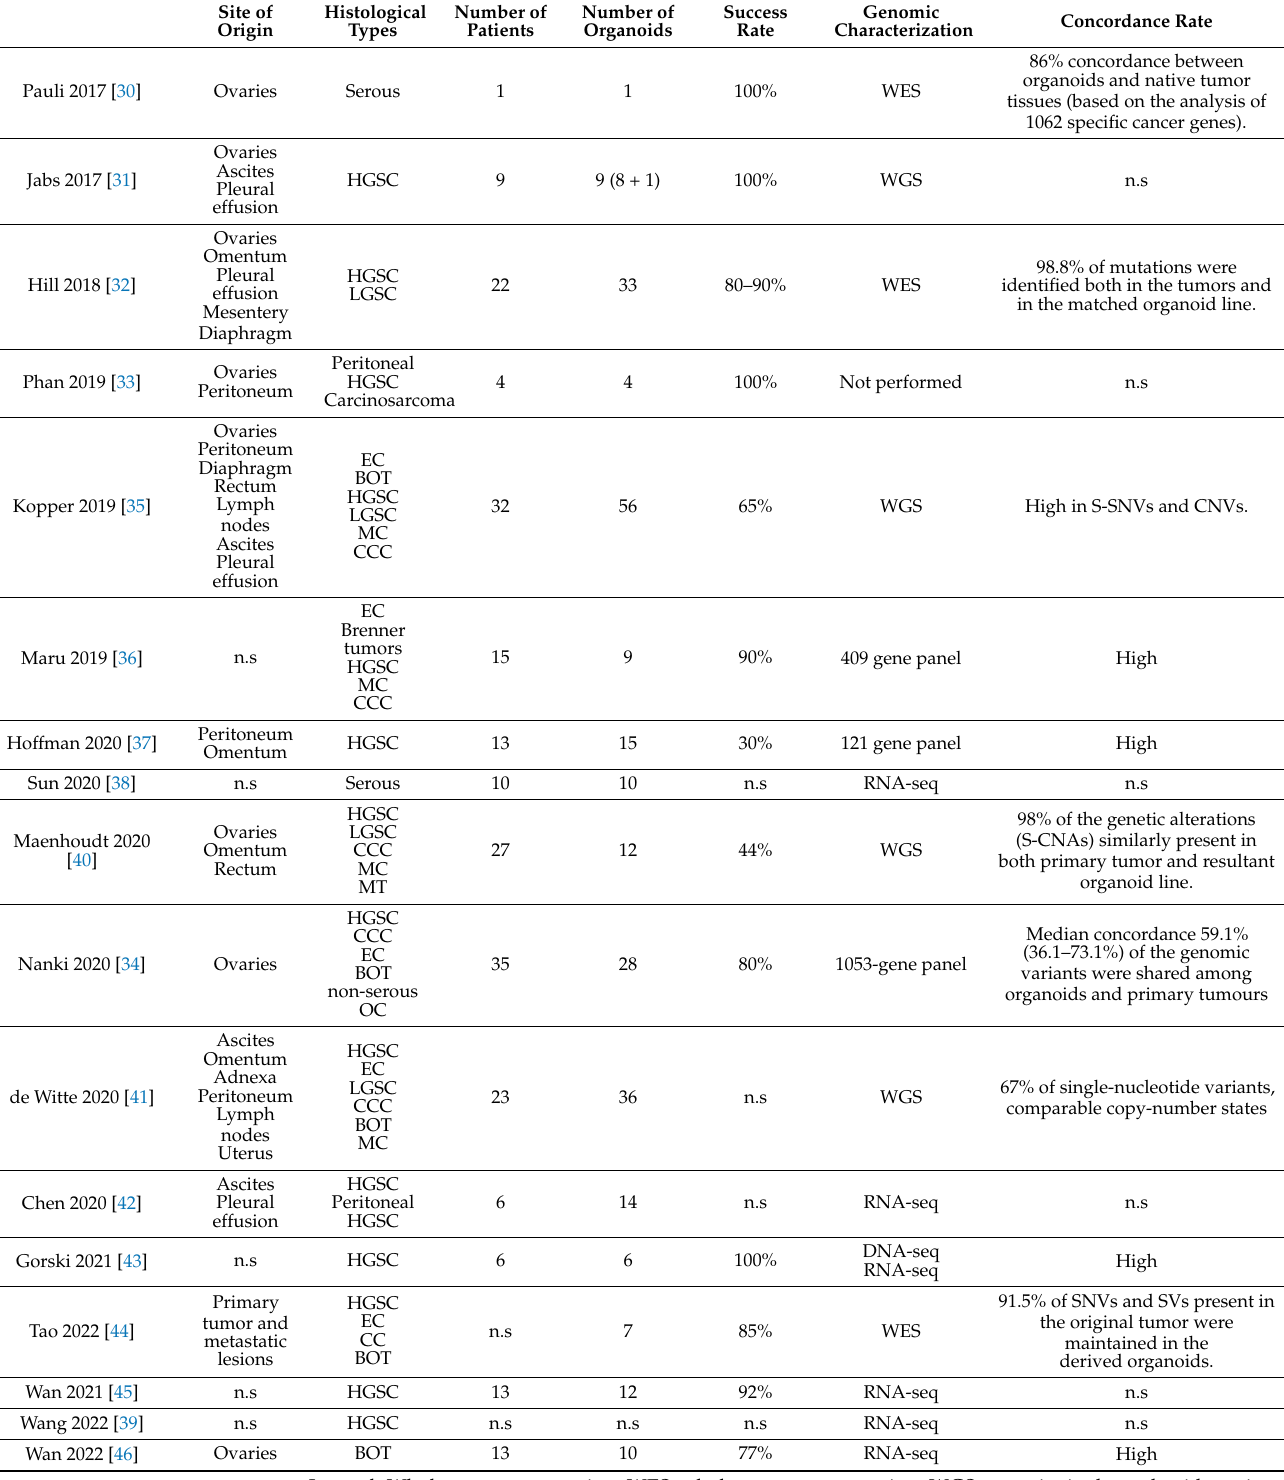
Table 1. Patient-derived organoids